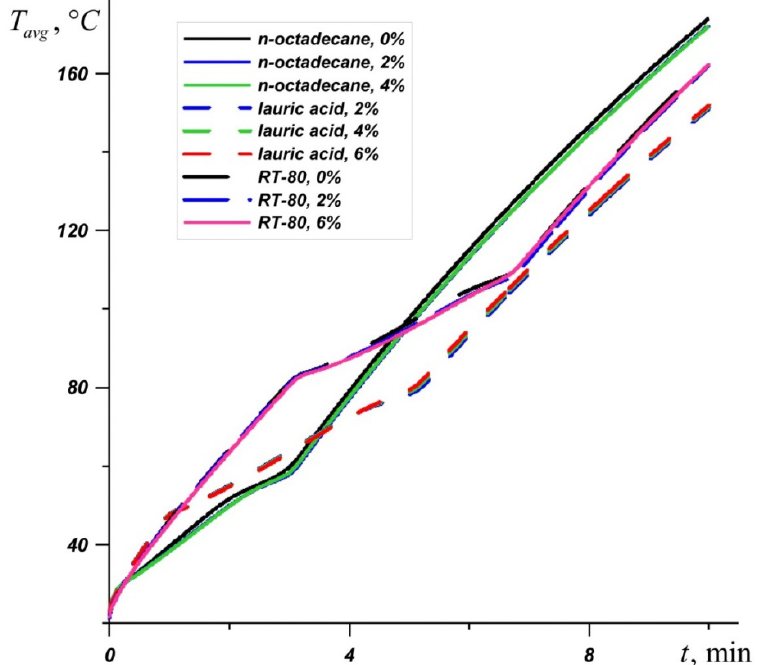
Figure 10. Evolution of average temperature in the source for n-octadecane, lauric acid, and RT-80 for different percentages of nanoparticles.